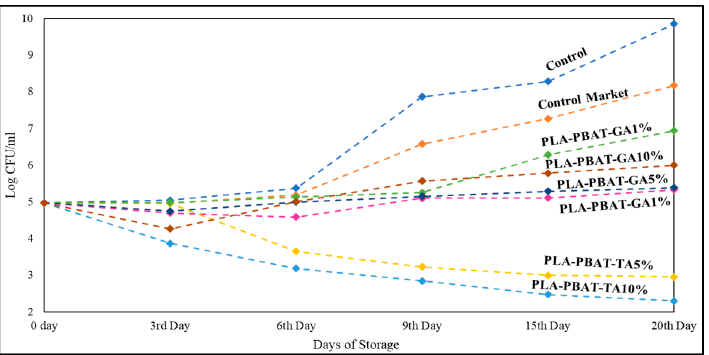
Figure 6. Effect of different packages on the total bacterial count of tomatoes stored for 20 days.